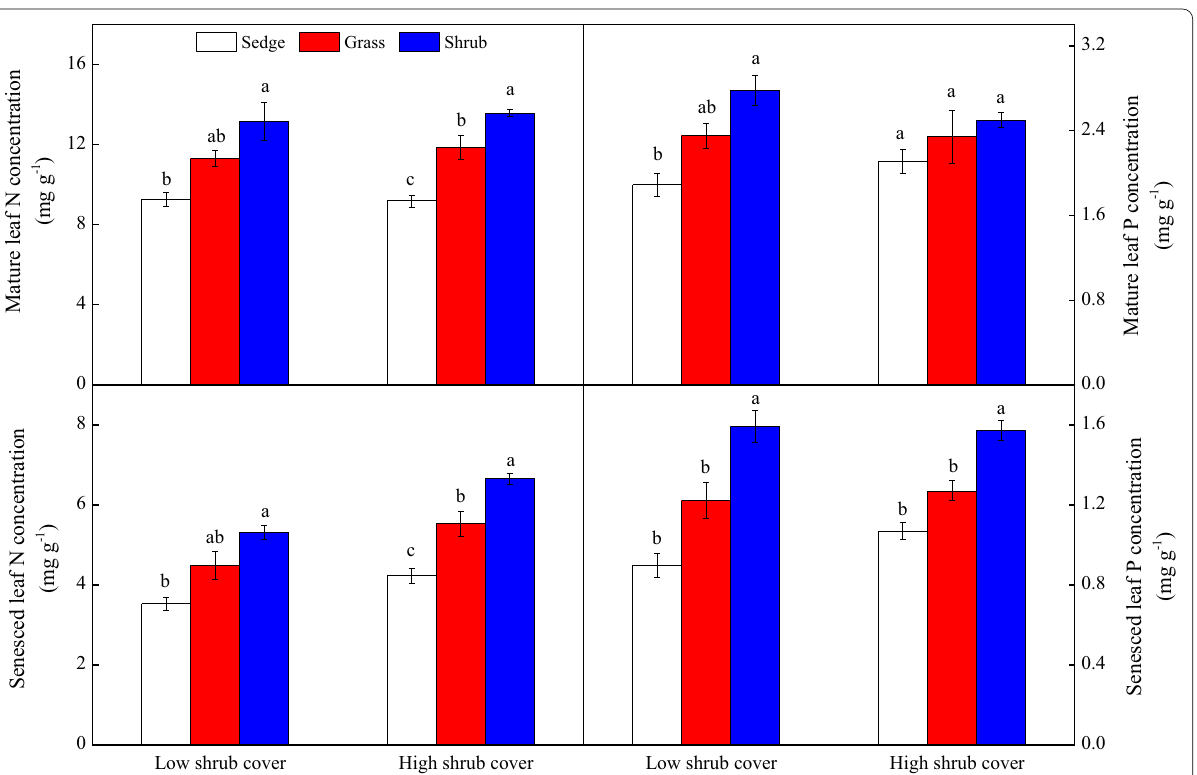
Fig. 1 Effect of shrub encroachment on leaf nutrient concentrations at the plant growth form level in freshwater wetlands of Northeast China. Error bars are the standard errors of the mean ( n 3). Different lowercase letters indicate the significant difference ( P < 0.05) among plant growth forms = within each wetland